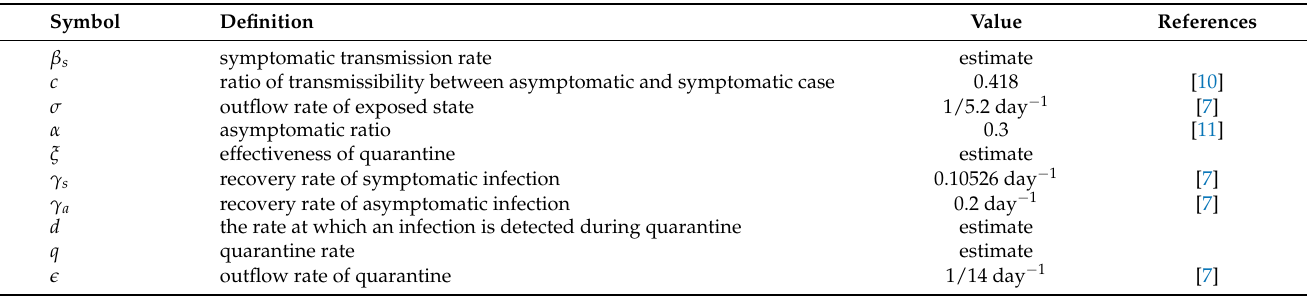
Table 1. List of model